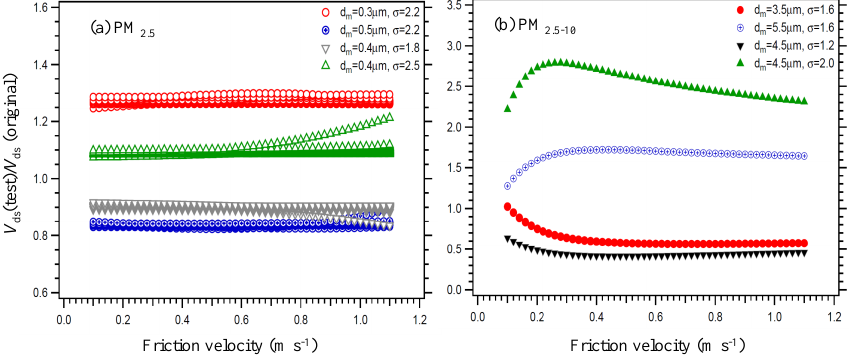
Fig. 6. The ratio of V ds from sensitivity tests to the original V ds vs. u ∗ (a) for PM 2 . 5 over all the LUCs and (b) for PM 2 . 5 − 10 over LUC 4. Table 2a. Empirical constants (in scientific format) for use in Eqs. (5) and (10) for Category 1 LUCs. LUC V ds (PM 2 . 5 − 10